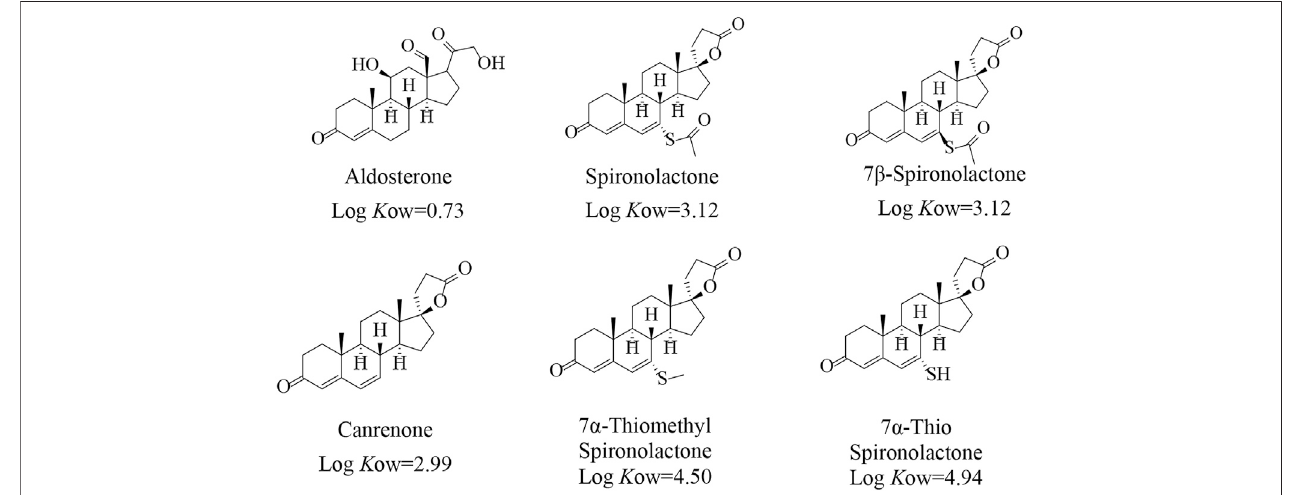
FIGURE 2 | Map of sampling sites in Taihu Lake. Numbers 1 – 30 represent the sampling sites.